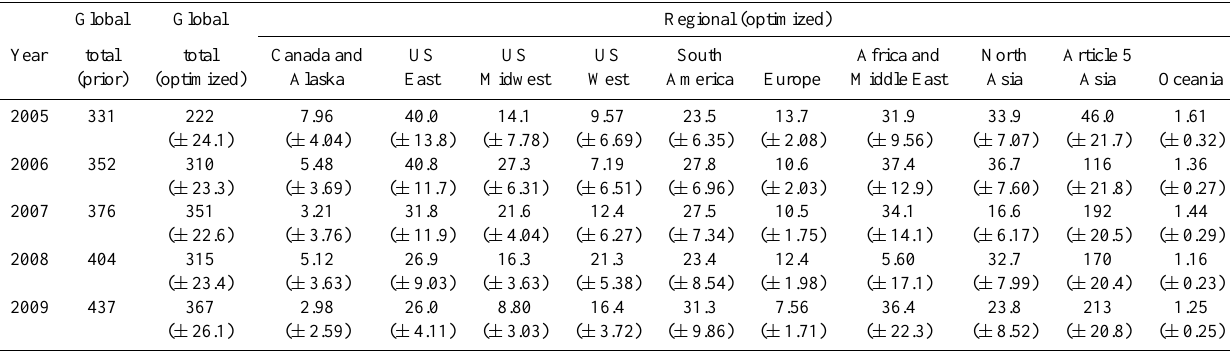
Table 3. Prior and optimized global annual HCFC-22 emissions and optimized emissions for each region based on the regional inversion with uncertainties (Ggyr − 1